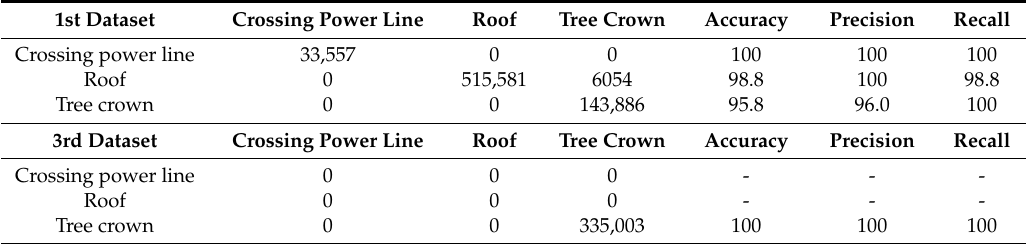
Table 7. Object recognition at point cloud level in SFD partition (in